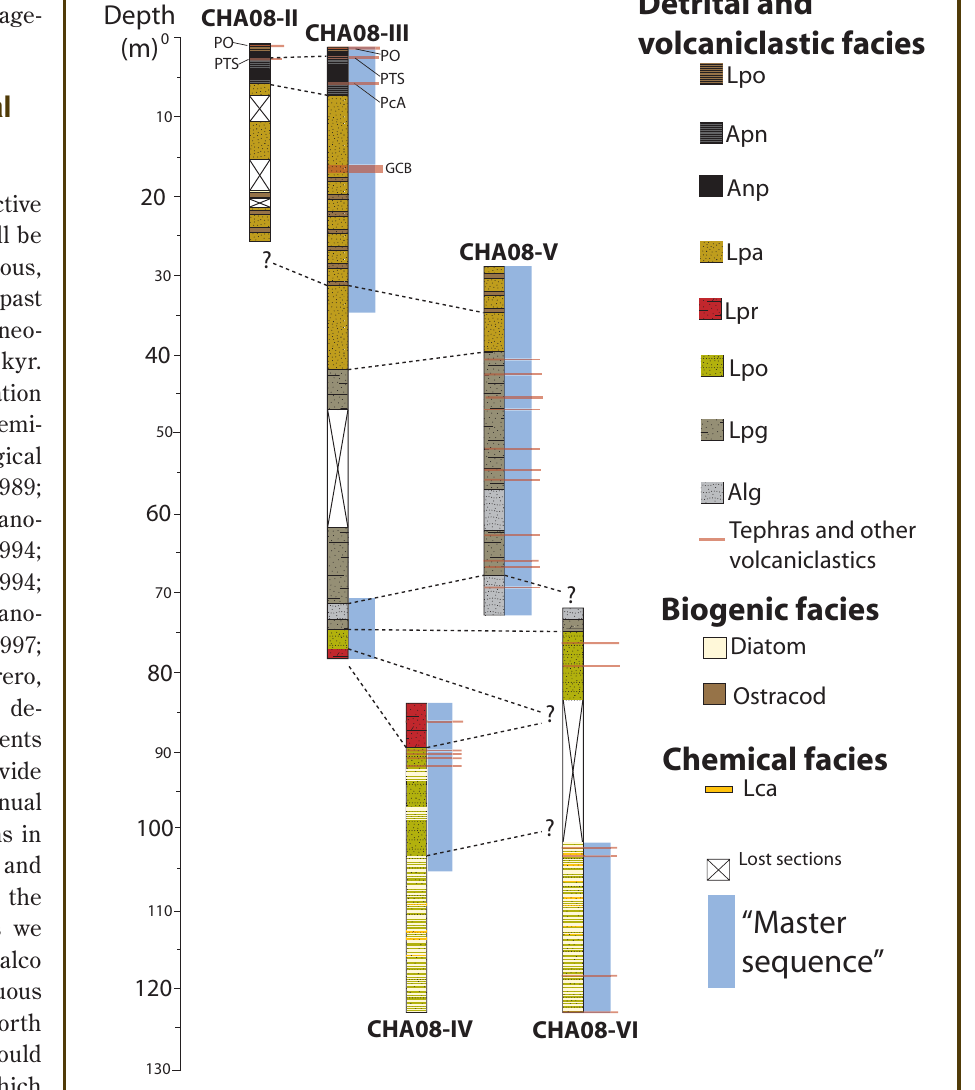
Figure 2. Stratigraphy of core recovered from Chalco in 2008 by UNAM researchers supported by UNAM funding. The base of this section (122 m) has a preliminary age assignment of ~220 ka, suggesting that the full 350–400-m sequence could represent 800 ky of sediment accumulation. Modified from Herrera-Hernandez